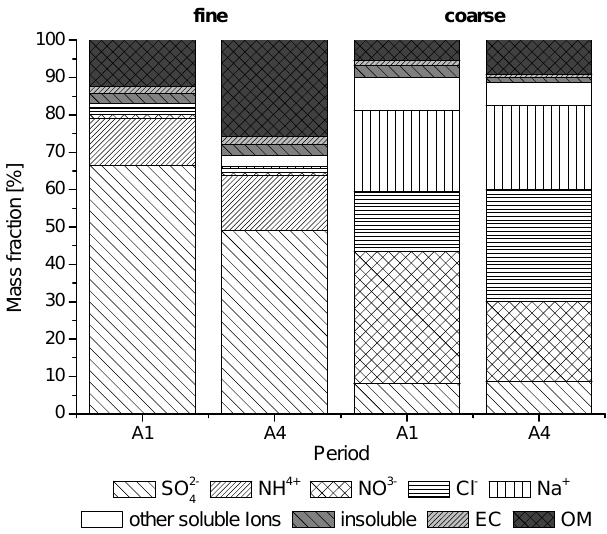
Fig. 6. Chemical composition of fine and coarse particles during the time periods A1 (marine) and A4 (continentally